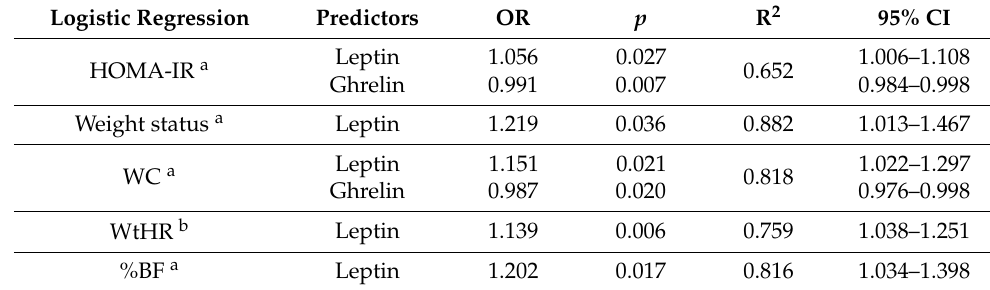
Table 5. Binary logistic regression of predictors of markers of obesity and glucose